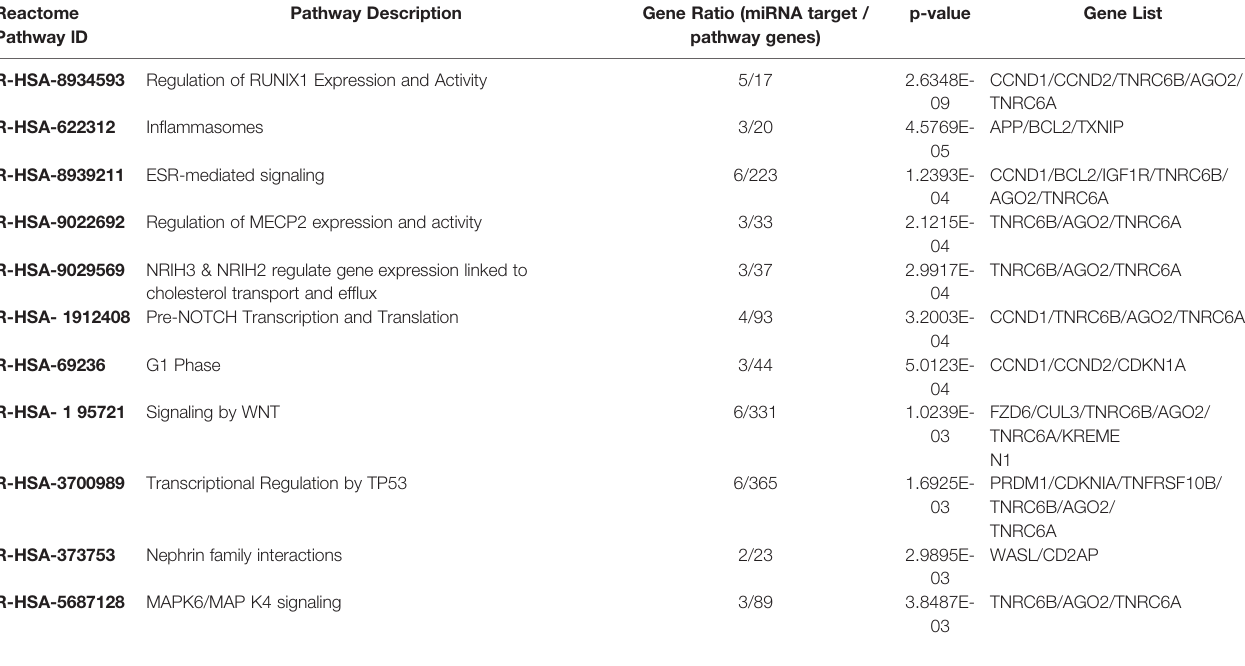
TABLE 3 | Representative pathways identi fi ed by the Reactome-PA